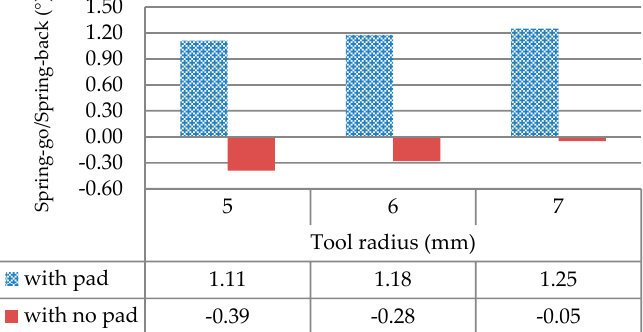
Figure 11. Comparison of the predicted spring-back/spring-go characteristics between the cases of U- bending, with and without pressure pads, with respect to tool radii (θ: 90°, W : 30 mm, t : 3 mm, WP L : 120 mm, R ud : 5 mm).